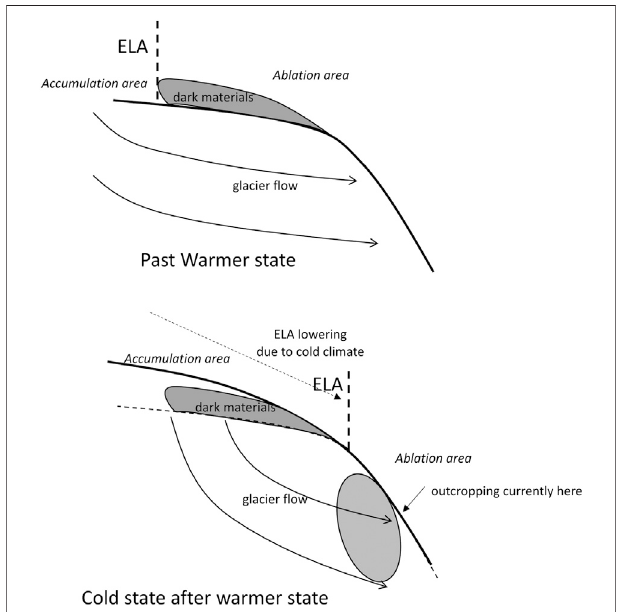
FIGURE 6 | Schematic drawing of accumulation of dark materials in warmer state and outcropping of dark materials in current state. Dark materials accumulated in Past Warmer state is conveyed with glacier fl ow in Cold States inside glacier, then is outcropping currently at intermediate of the